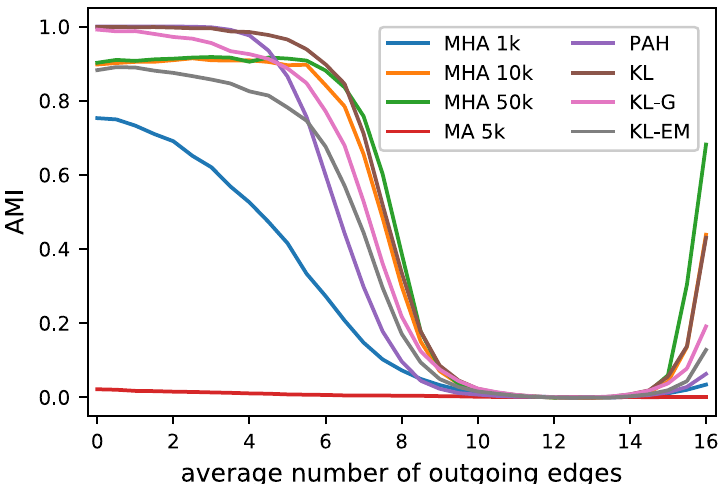
Fig 5. Overview of the performance of the applied inference algorithms. The results shown are based on the same 10 executions for each of the 10 networks for each SBM variant of Fig 4, which are the basis for Fig 4. The value shown are the mean of all executions, all networks with the same k out and all SBM variants (of Fig 4). Fig 6 includes the results for selected inference algorithms for individual SBM variants.